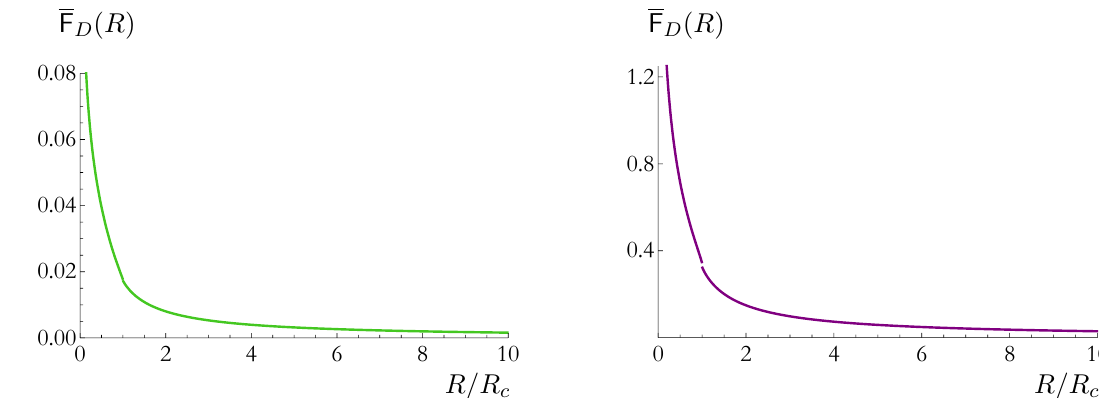
Figure 8. Measure of the flow of the degrees of freedom in the gapped non-confining theory B 0 (Left) and in the confining one B conf (Right). Notice that we plot rescaled quantities as explained 8 in appendix C, as a function of the radius of the disk normalized to the smallest radius for which the RT surface reaches the